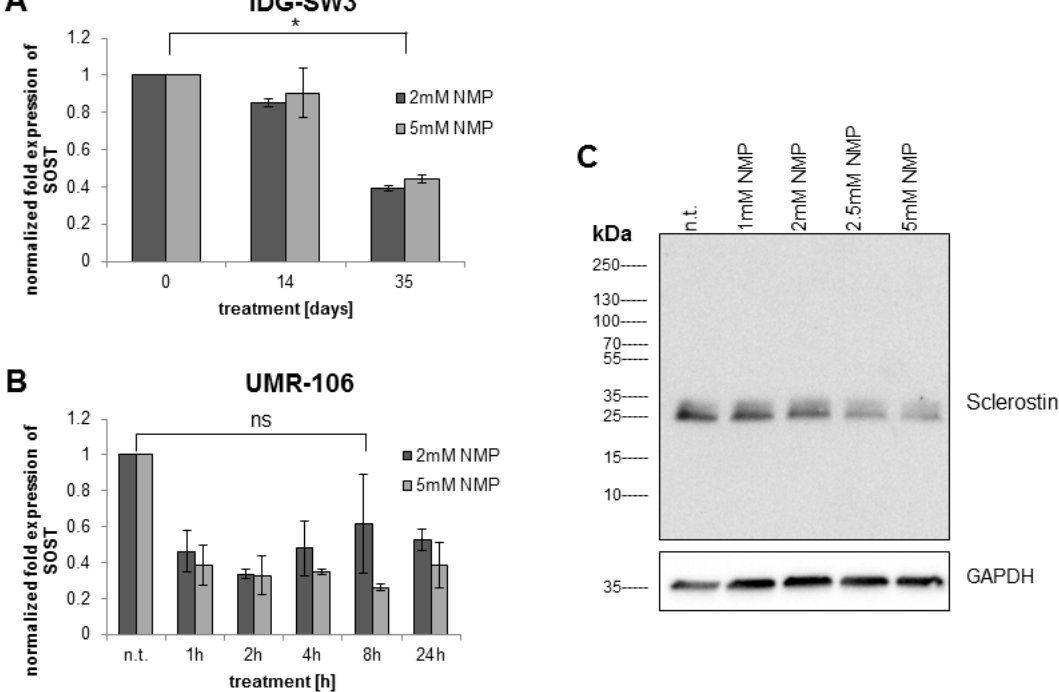
Figure 2. NMP decreases sclerostin mRNA and protein expression. ( A ) Immortalized mouse IDG-SW3 cells were stimulated with 2 mM (dark bars) and 5 mM (light bars) NMP during the whole period of differentiation. ( B ) Rat osteosarcoma UMR-106 cells were incubated with 2 mM (dark bars) and 5 mM (light bars) NMP over a time period of 24 h. ( C ) UMR-106 cells were treated for 8 h with the indicated NMP concentrations in normal culture medium. Whole cell lysates were subjected to Western Blot analysis indicating an NMP concentration-dependent reduction in sclerostin expression. The star indicates statistical significance at α = 0.05, while “ns” indicates non-significance at the same threshold.